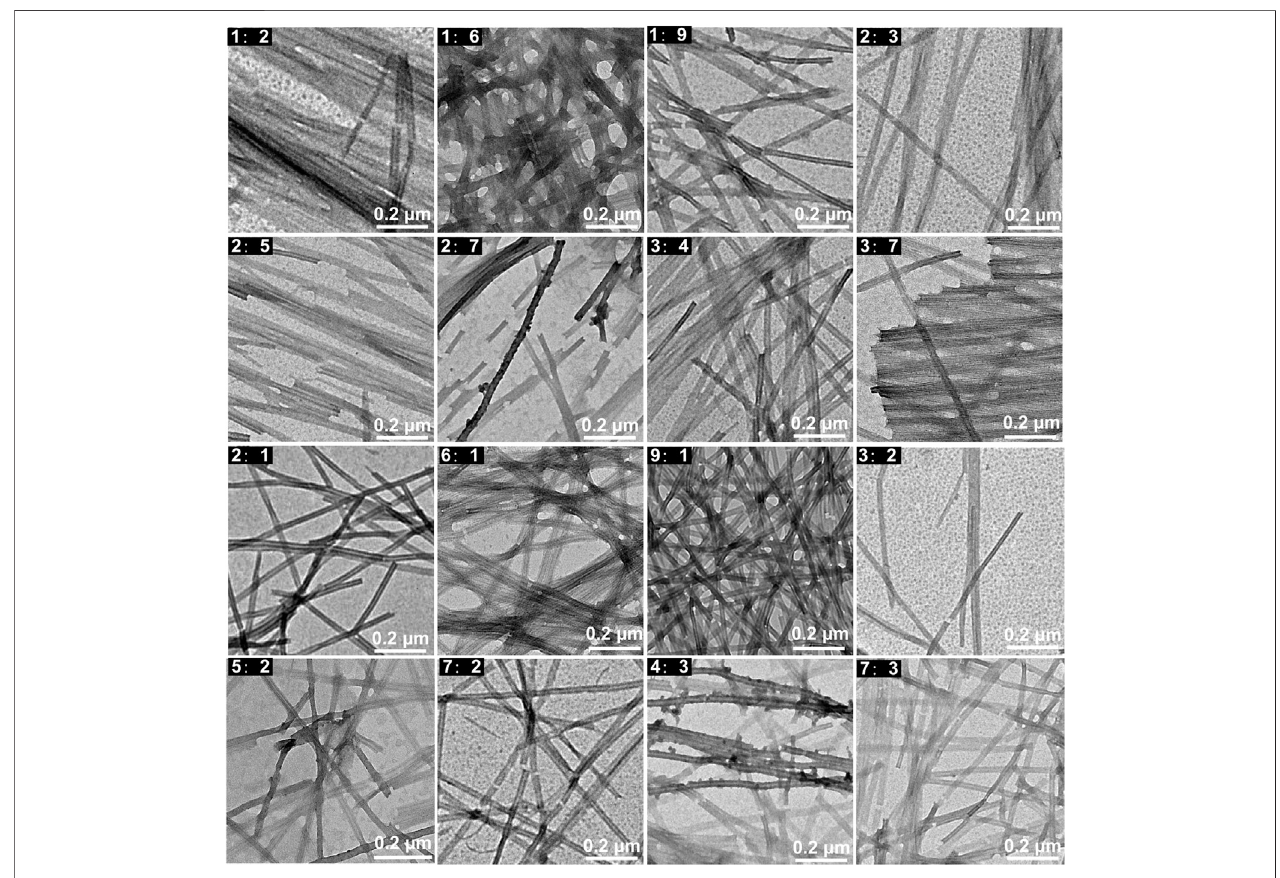
FIGURE3| TEMimagesofthenanowiresco-assembledbyKK-11andKKd-11withdifferentconcentrationratios(1:2,1:6,1:9,2:3,2:5,2:7,3:4,3:7,2:1,6:1, 9: 1, 3: 2, 5: 2, 7: 2, 4: 3, 7: 3).